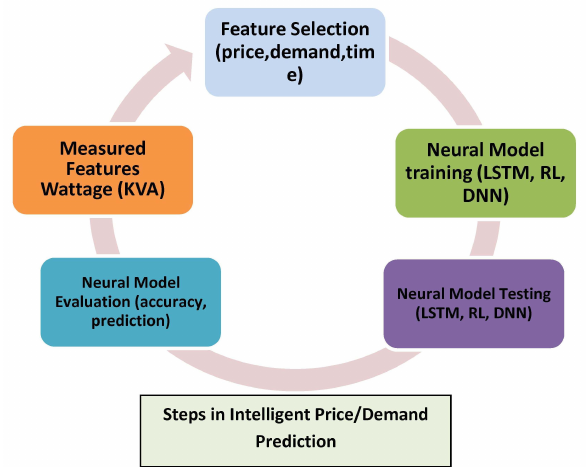
Figure 1. Intelligent price and demand